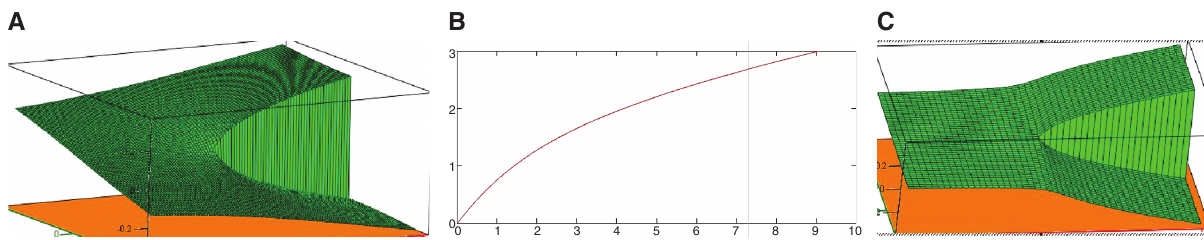
Figure 4 (A) classical solution, (B) gradient elasticity crack profile/Eq. (6), (C) full field solution/Eq.